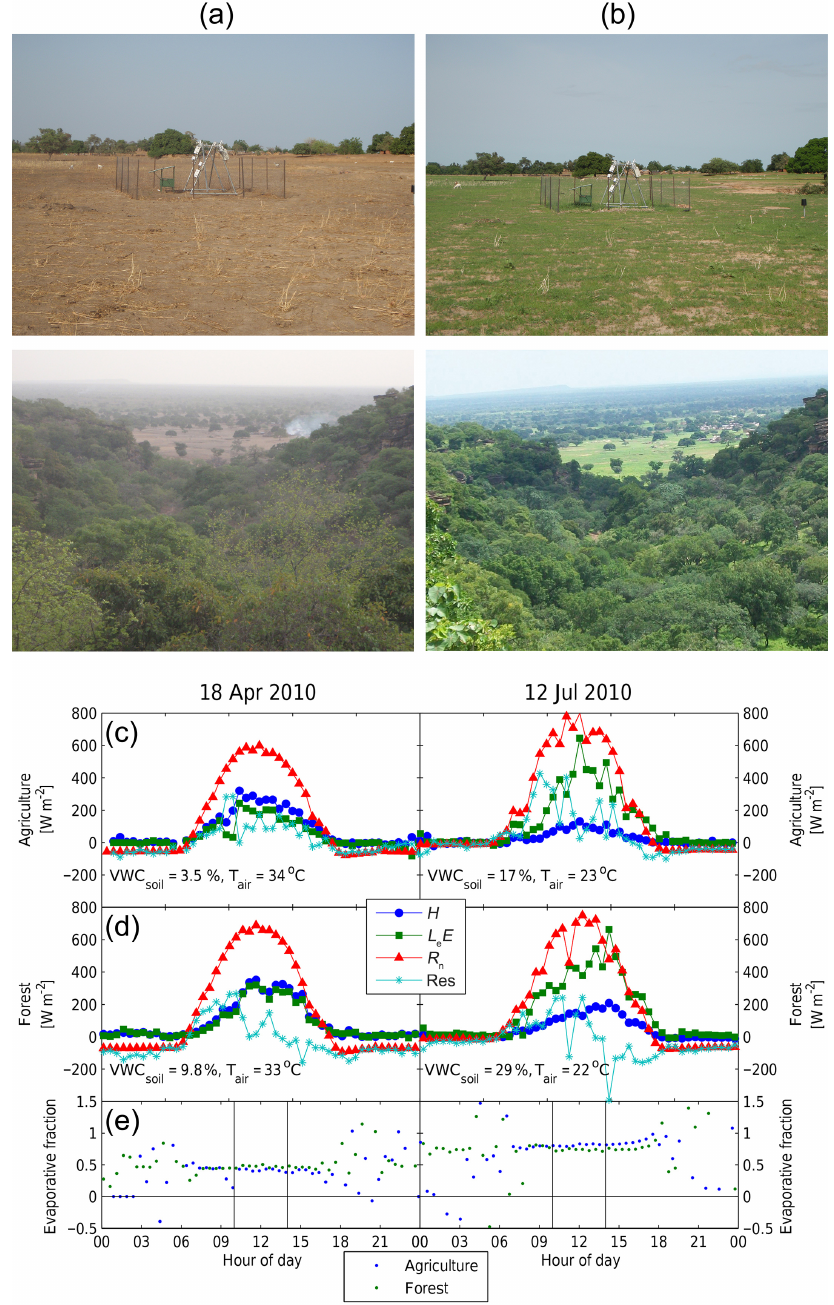
Figure 3. The diurnal cycle of the energy balance. The upper four photographs correspond to the four subplots – the date of the photograph is the same month as the representative plot of diurnal energy budget. Note that April (a) was the dry season and the atmosphere was very hazy, in part due to fires. July was the start of the rainy or wet season (b) . The energy budget is made up of the sensible heat ( H , blue), latent heat ( L e E , green), net radiation ( R n , red) on the y axis (Wm − 2 ) over the savanna forest (d) , and agricultural land (c) according to the time of day ( x axis, 24h). The residual of the energy budget is also shown in turquoise. The final row shows the half-hour calculation of evaporative fraction. Daily averages were taken between 10:00 and 14:00UTC, shown with the vertical lines, with the savanna forest in green and agriculture in